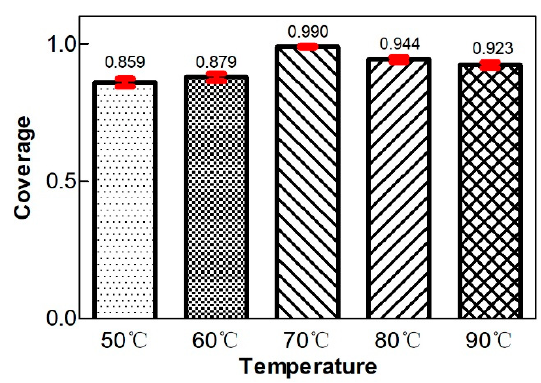
Figure 10. Coverage comparison based on temperature.